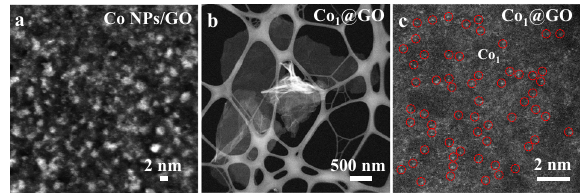
Fig. 2 Electron microscopy images. HAADF-STEM images of a Co NPs/ GO and b , c Co 1 @GO, with the red cycle areas of Co 1